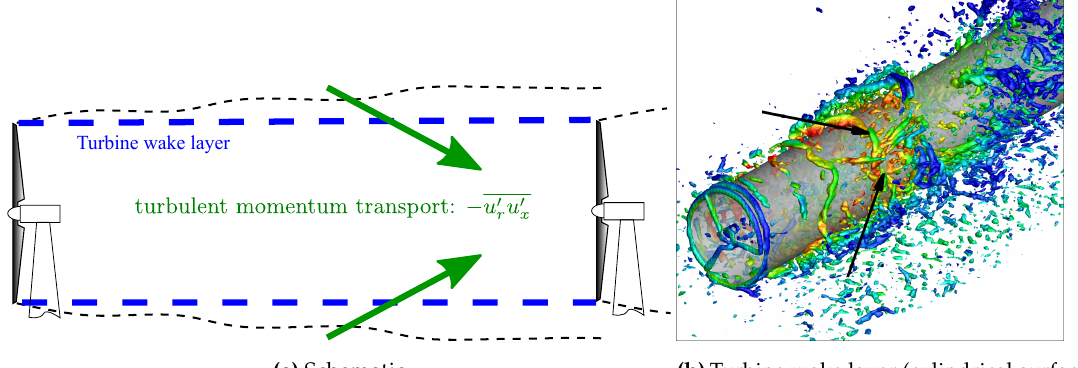
Figure 14. Investigation of turbulent momentum transport into the turbine wake layer: ( a ) a schematic; and ( b ) cylindrical surface showing the turbine wake layer through which turbulent momentum flux is computed to quantify entrainment in the turbine